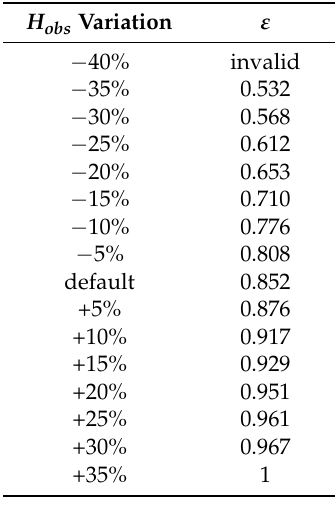
Figure 5. ( a ) Dependence of the surface emissivity ( ε ) on the RMS in H obs and H sfc in near neutral conditions at Xiaotang from 5 January to 31 December 2010. ( b ) Dependence of the surface emissivity ( ε ) on density according to the surface temperature method. ( c ) Retrieval of the surface emissivity from Landsat data. Table 4. Difference in ε with H obs according to the method employed.